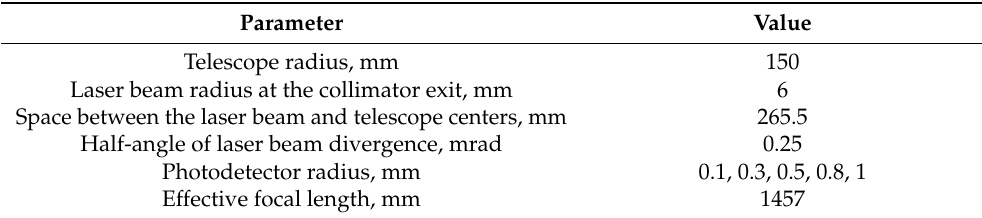
Table 2. Input data for simulation of the geometrical function of the lidar.